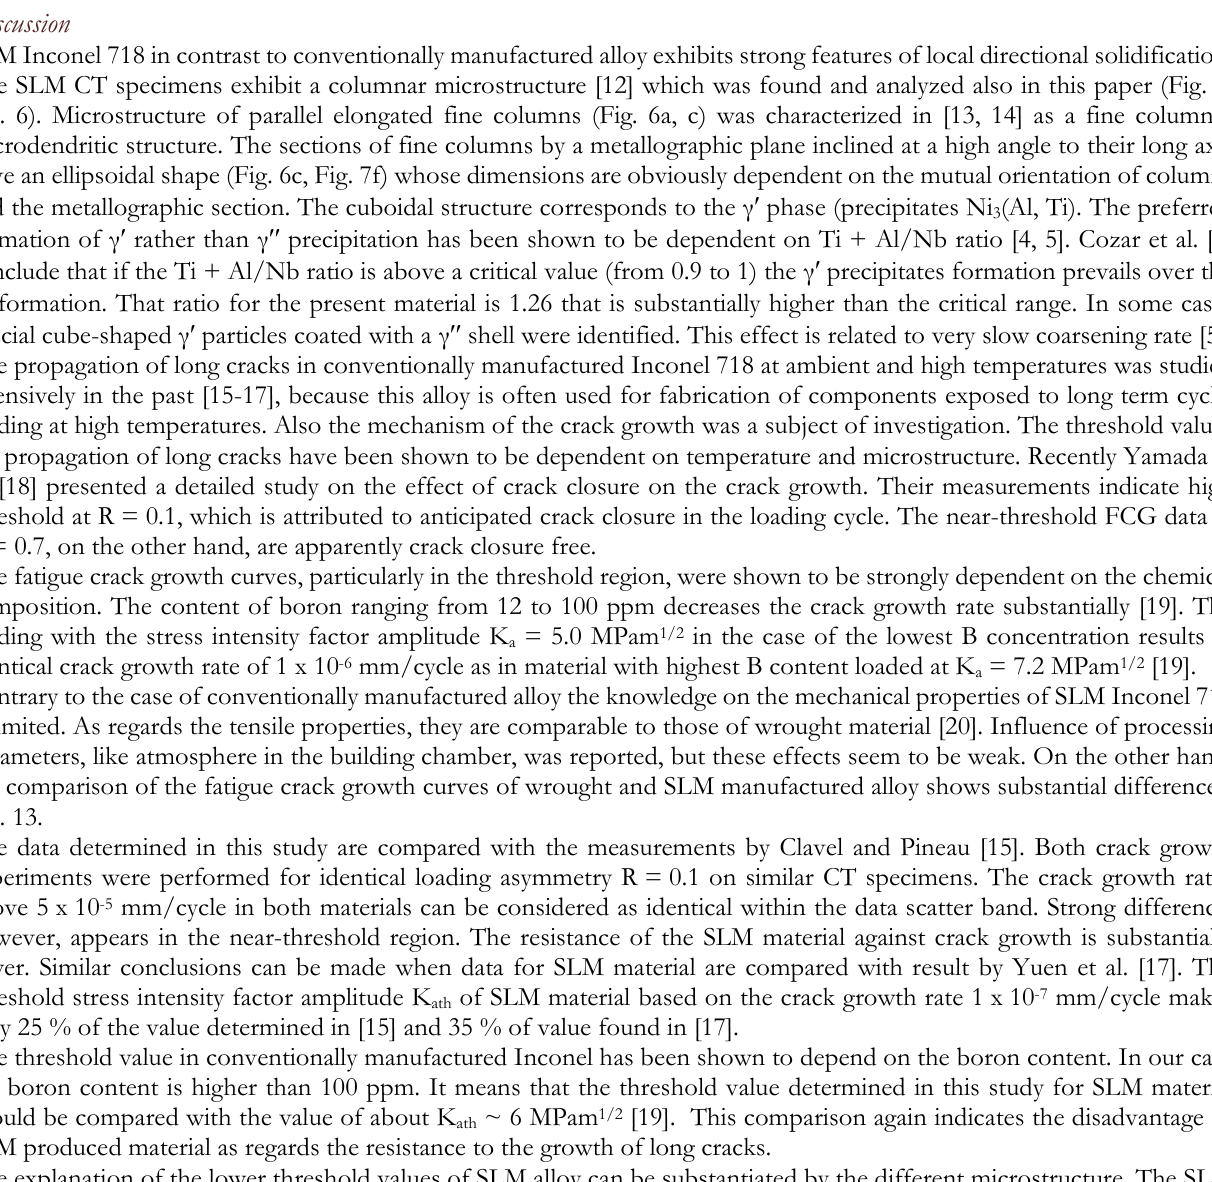
Figure 12 : Fracture profiles of fatigue crack path,